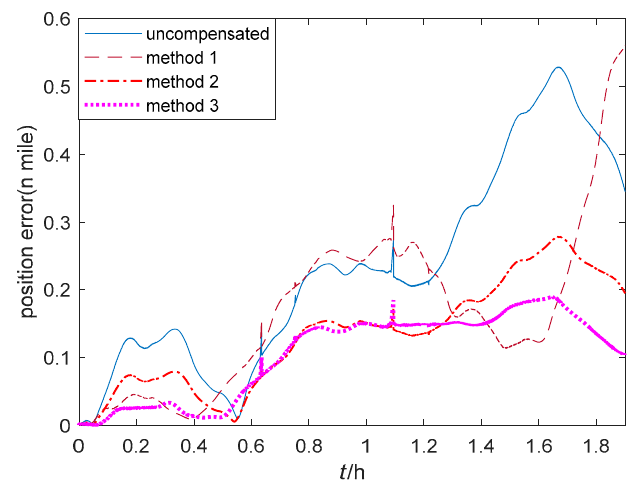
Figure 16. Position errors of the vehicle navigation experiment.